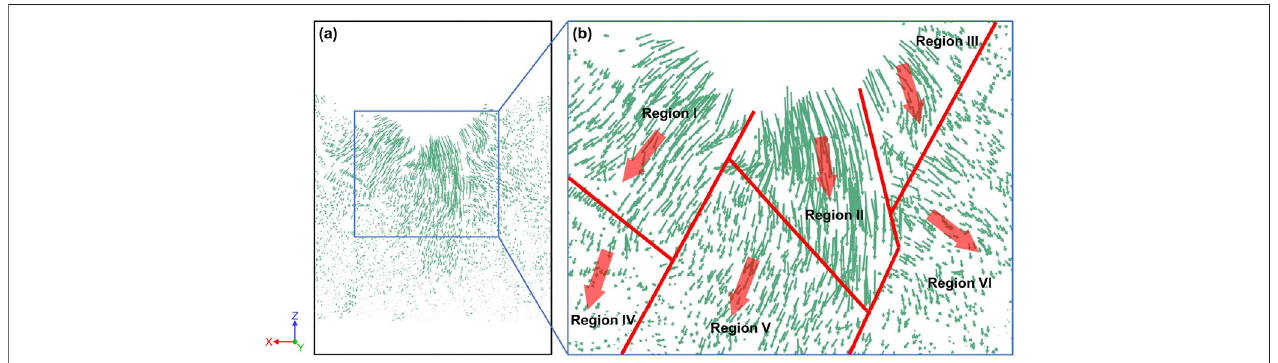
FIGURE6| Differentadjustment behaviorsofvitrinitemolecularchains: (A) slidingbetweenaromatic structure, (B) reorientation ofaromatic lamella, (C) bendingof aromatic chains.